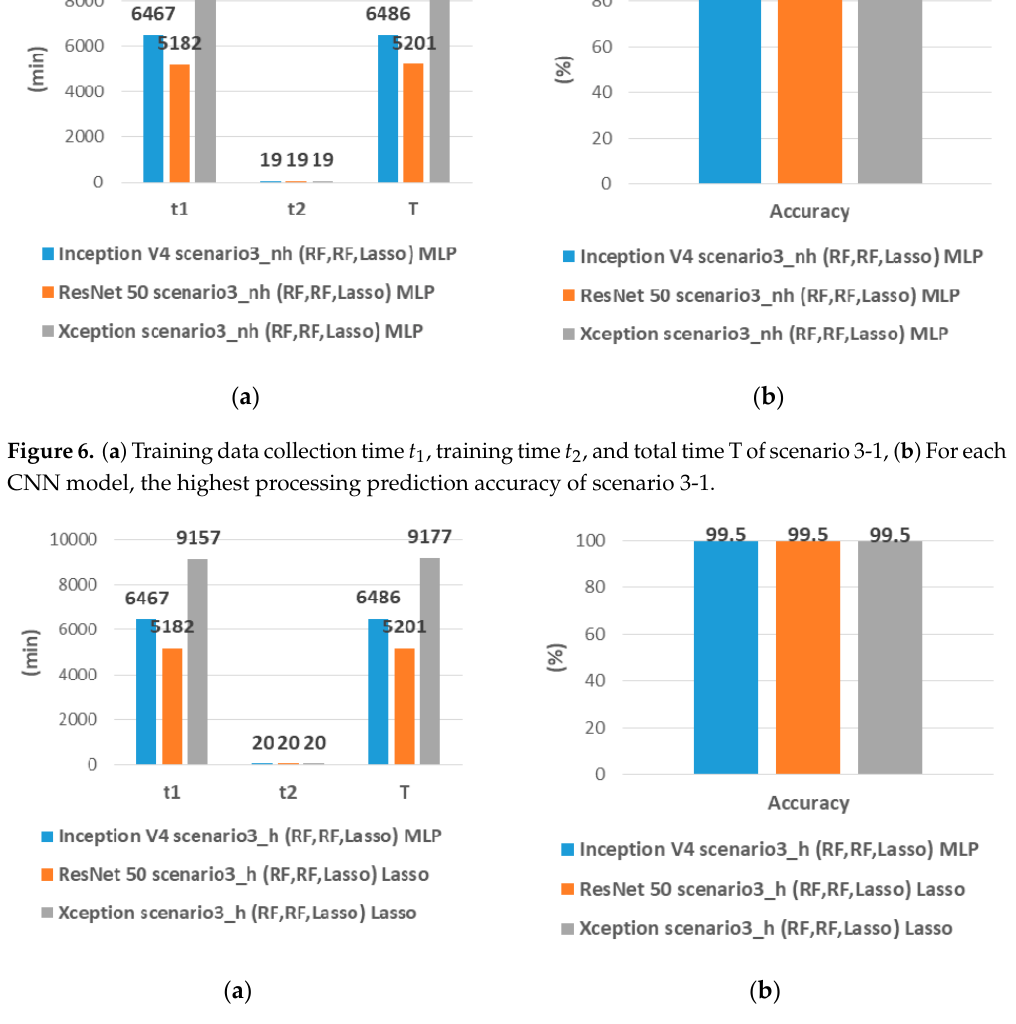
Figure 7. ( a ) Training data collection time t 1 , training time t 2 , and total time T of scenario 3-2, ( b ) For each CNN model, the highest processing prediction accuracy of scenario 3-2.